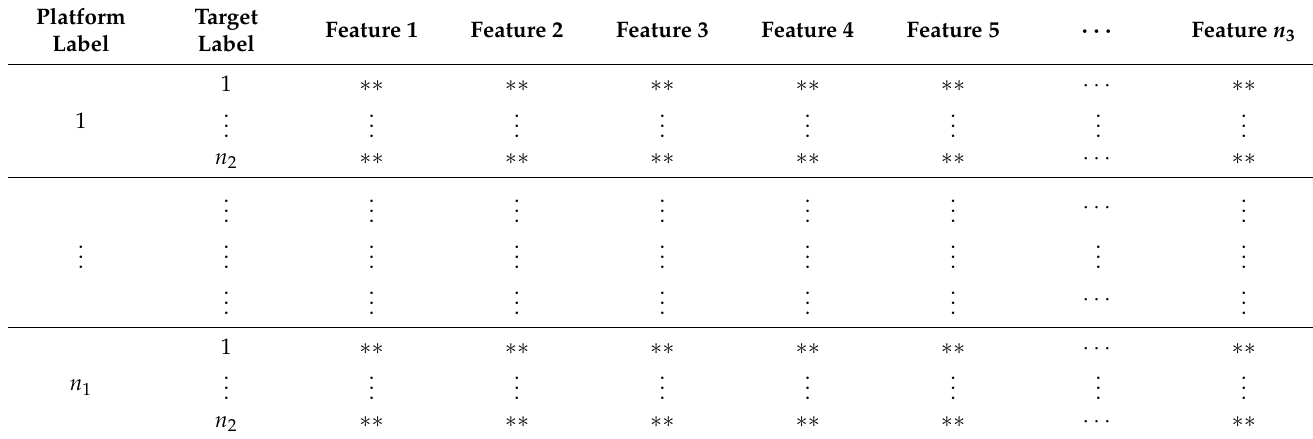
Table 1. An illustration of annotation information of electronic reconnaissance data. Platform